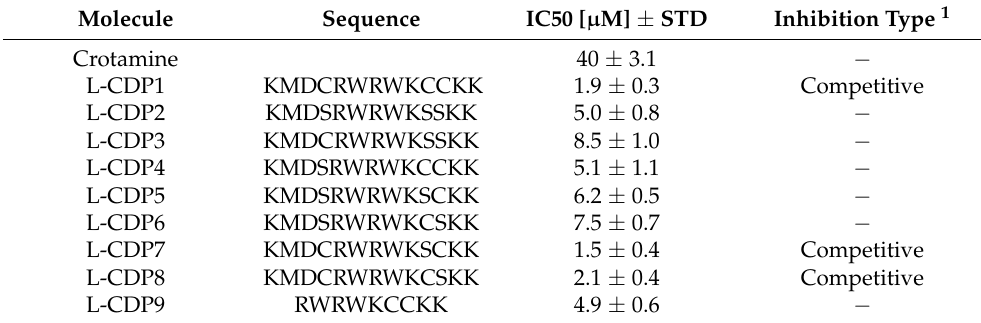
Table 1. Summary of the SARS-CoV-2 3CL pro inhibition experiments by crotamine and CDPs. Molecule Sequence IC50 [ µ M] ± STD